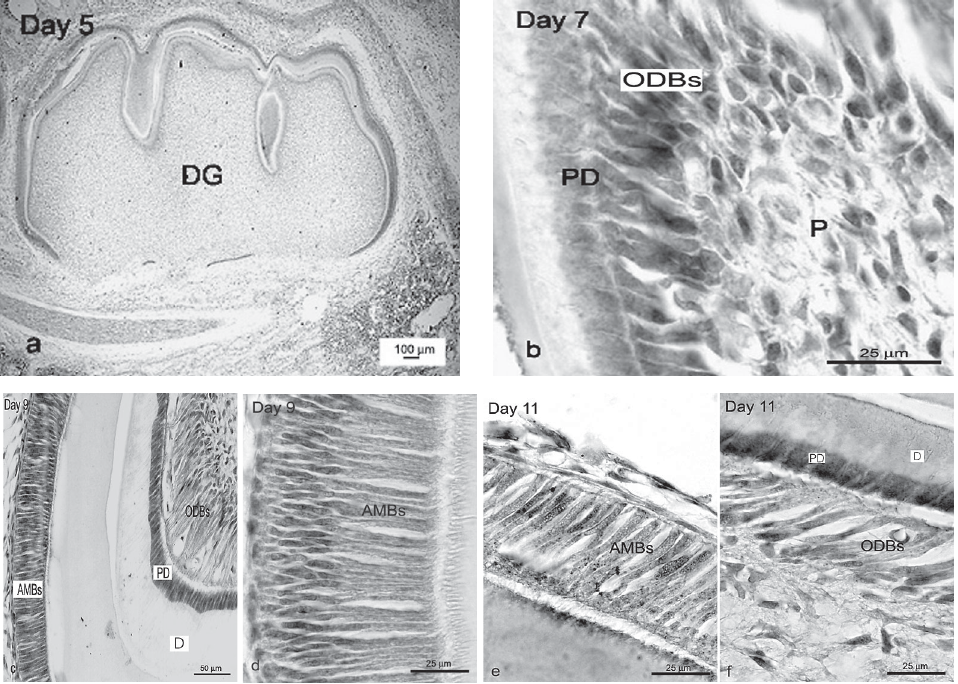
Figure 1. Immunocytochemical detection of biglycan in dental germs of rats aged 5-11 days. On day 5, the immunoreaction is usually weak (a). On day 7 a strong reaction is observed in odontoblasts and predentin and in the peripheral zone of the pulp (b). On day 9, a strong signal for biglycan is observed in amelo- blasts, predentin and odonto- blasts, whereas a weak signal is observed in the pulp (c). Higher magnification showing the reac- tivity in ameloblast cells at day 9 (d). On day 11 a slight reactivity for biglycan is observed in ameloblasts (e). Another view of day 11 showing that a strong re- activity remains in predentin, whereas the reaction in odonto- blasts is weak (f). AMBs - amelo- blasts; D - dentin; DG - dental germ; ODBs - odontoblasts; P - pulp; PD -